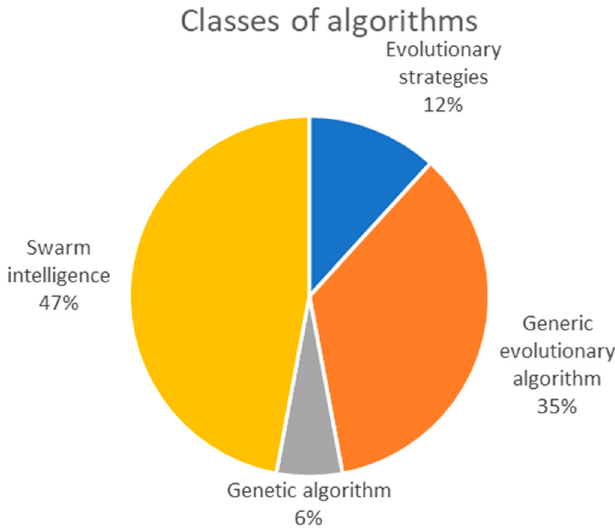
Figure 2. Repartition of main classes of algorithms in reviewed articles.